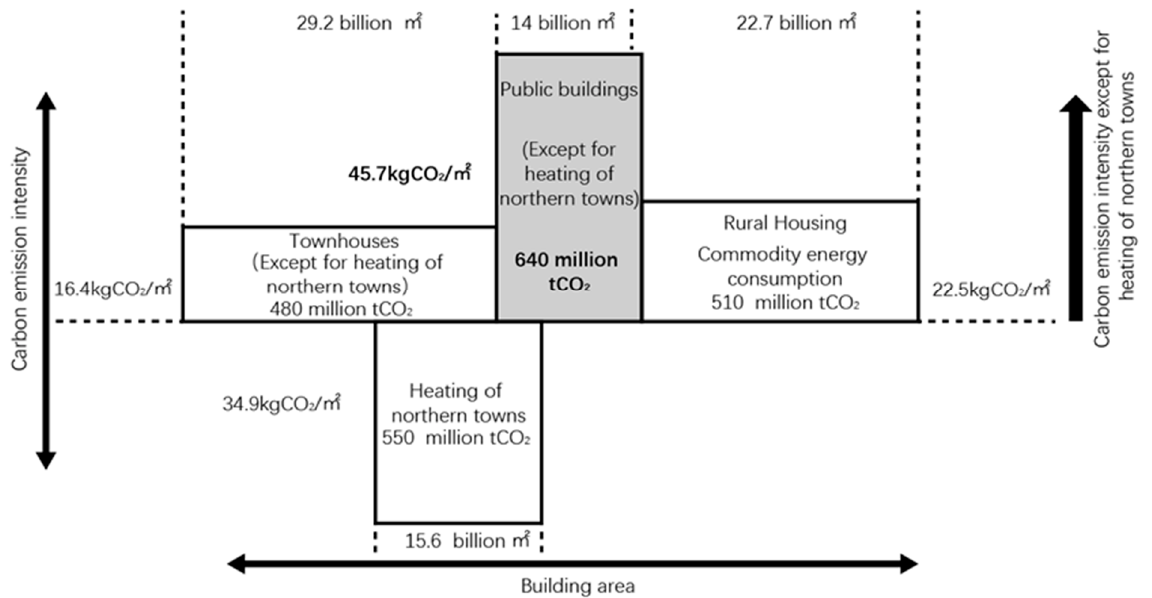
Figure 2. CO 2 emissions associated with building operations in China